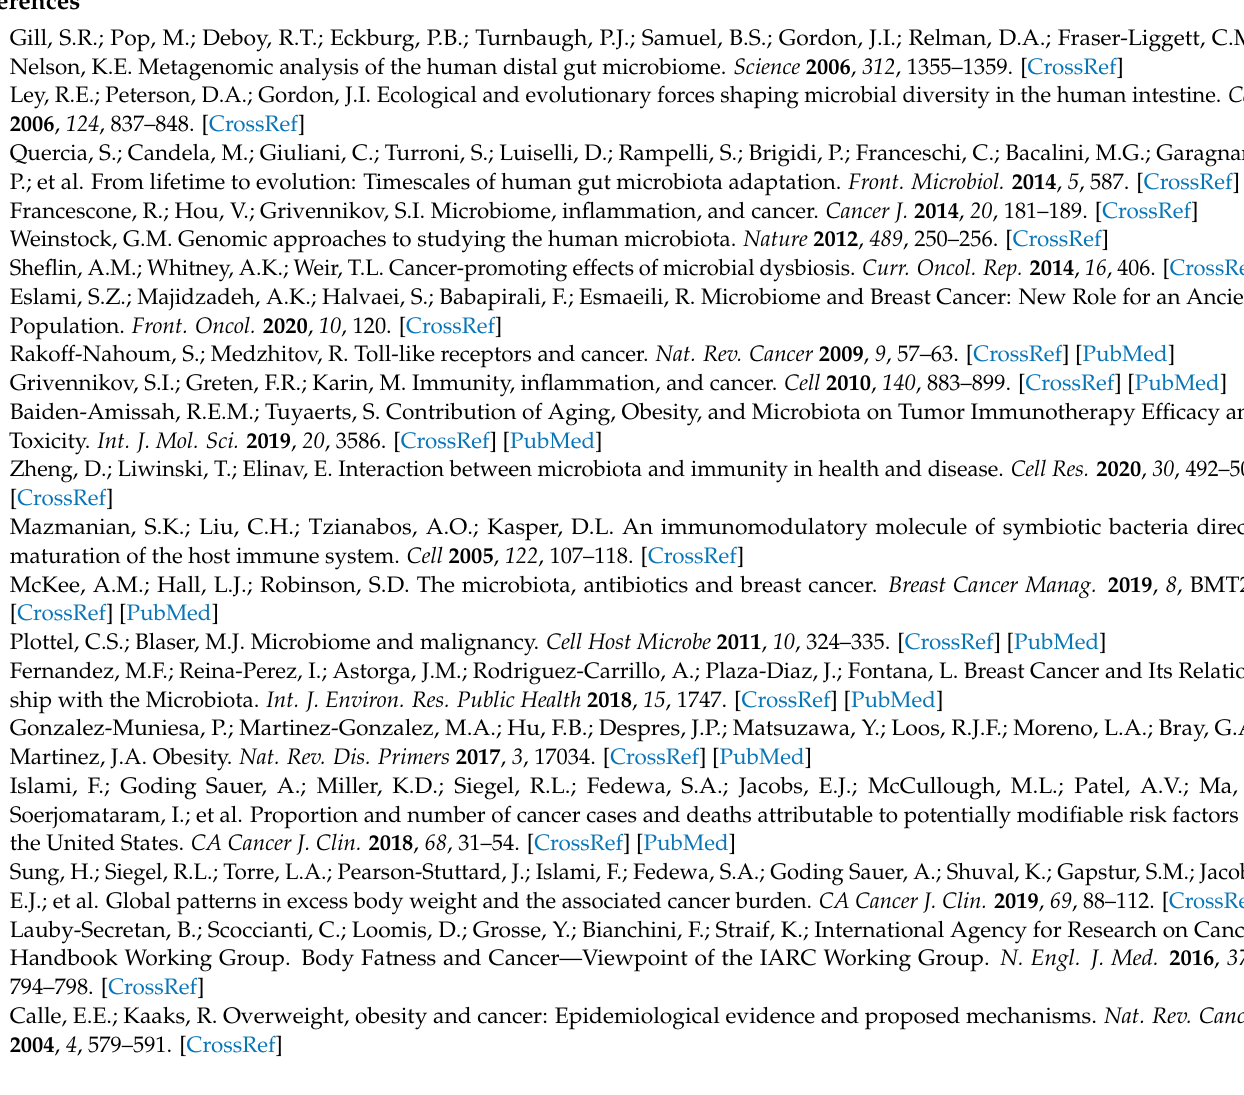
Table S2: Sequence statistics of alpha diversity. Supplemental Figure S2: Metagenomic analysis: taxonomic composition at the kingdom and phylum level. Supplemental Table S3: Richness Table: Differences in pathway richness according to Obesity and Tumor